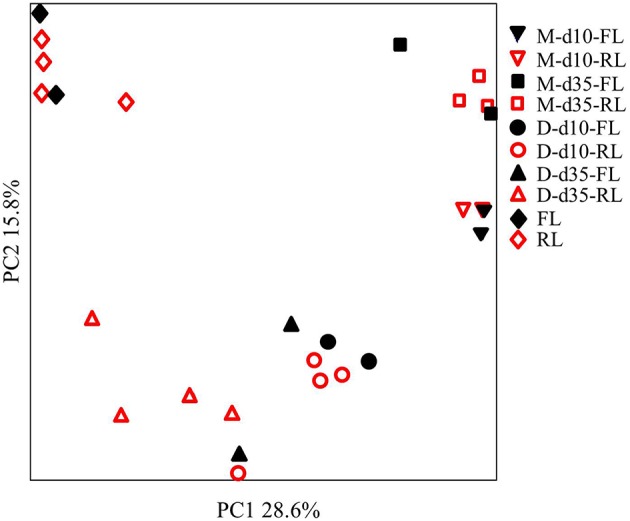
Principal component analysis (PCA) plot of the DGGE profiling of the microbiome. M, ileal mucosa; D, cecal digesta; d10 and d35, samples collected at 10 and 35 days, respectively, of bird age; FL, fresh litter; RL, reused litter. Some samples were superposed due to identical DGGE profiles.